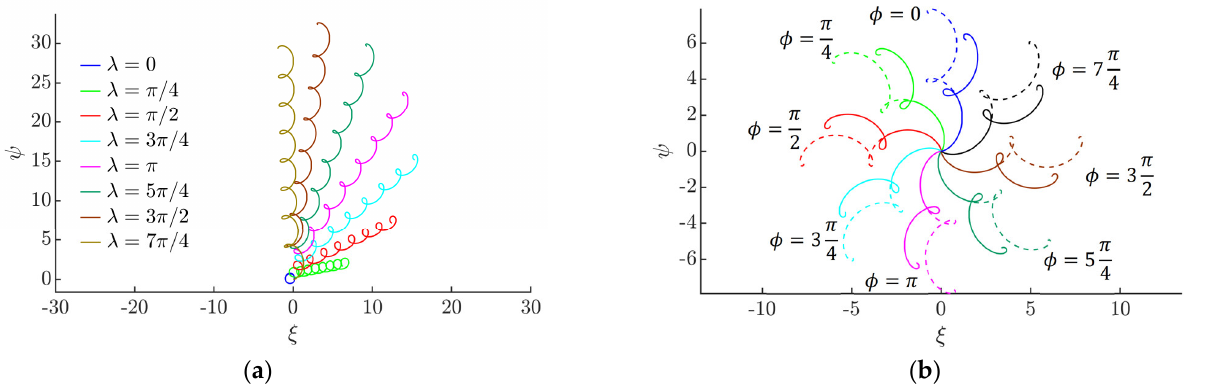
Figure 5. Trajectories of the particle: ( a ) under different values of λ after 8 cycles of the circular motion of the platform when ϕ = 0, μ 0 = 0.2, ⟨ μ m ⟩ / μ 0 = 0.25, γ = 4; ( b ) under different values of the phase shift ϕ after two cycles when μ 0 = 0.2, ⟨ μ m ⟩ / μ 0 = 0.25, γ = 4.9, λ = π (solid line), λ = 13 π /9 (dashed line).